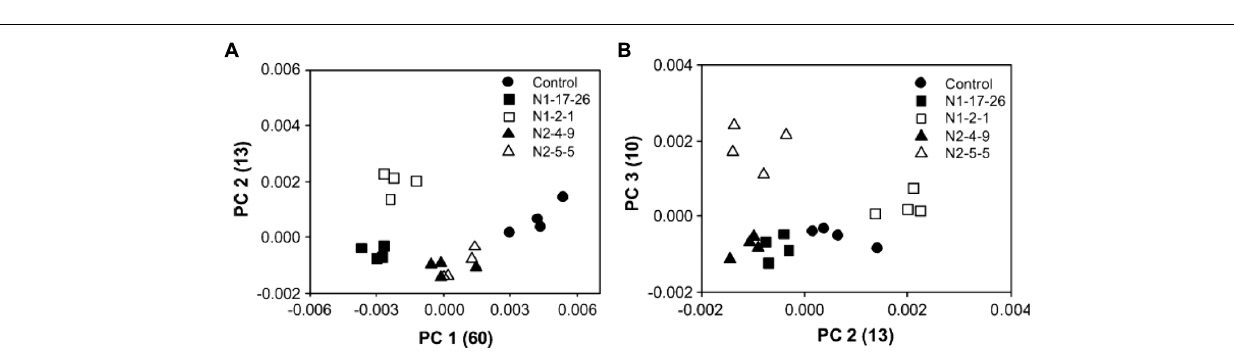
FIGURE 4 | Scores plot of PCA of Py-mbms data for original and transgenic aspens; (A) PC1 versus PC2; (B) PC2 versus PC3; N1 samples are clearly separated from control samples in (A) while two N2 samples are not distinguishable; in (B) two N2 samples are clearly separated by PC3 as reproduced from literature (Labbe etal.,